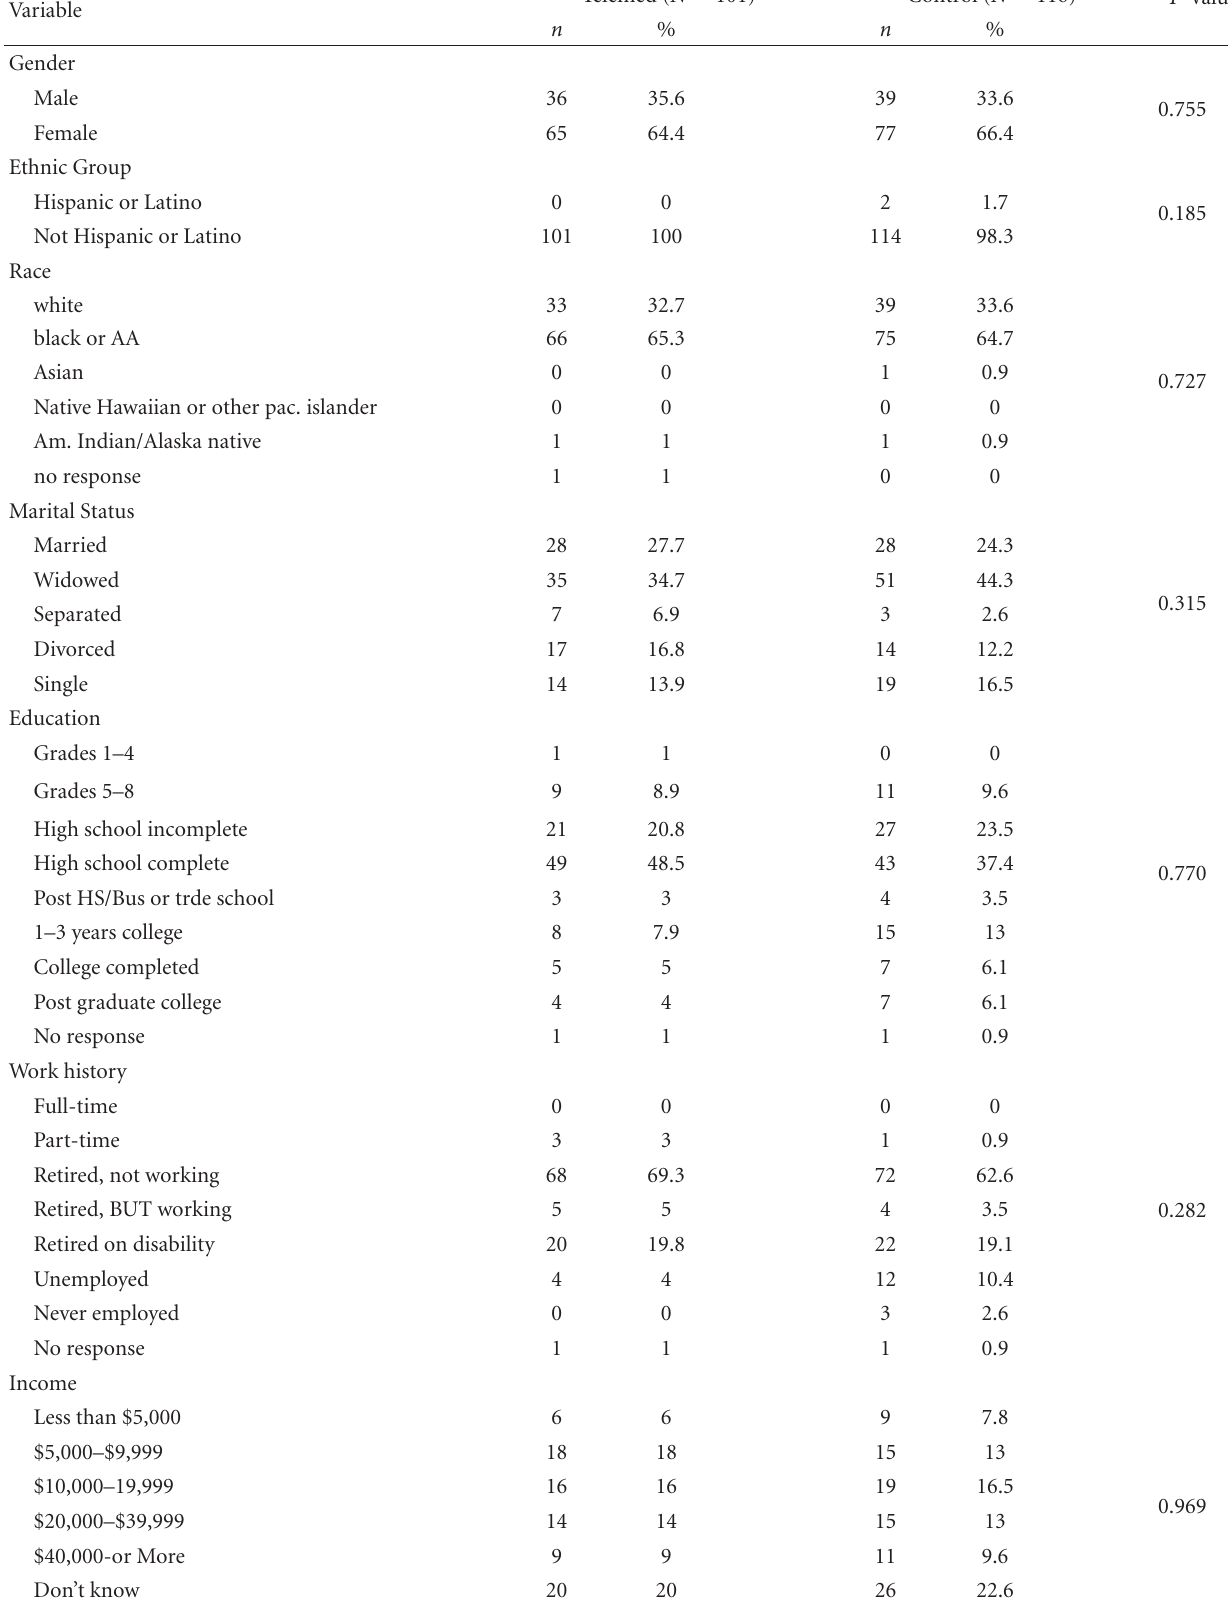
Table 2: Sociodemographic and baseline clinical characteristics of ITT subjects by treatment